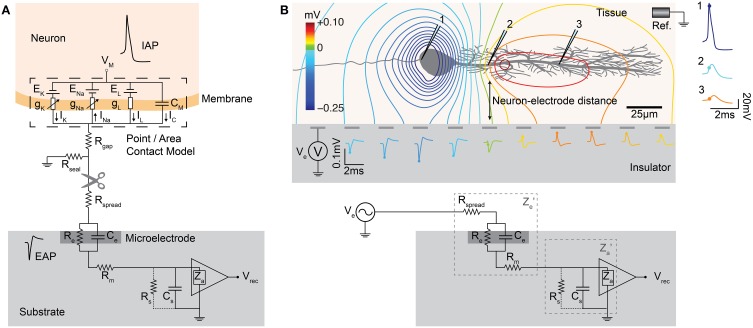
MEA neuron-electrode interface. (A) The classic point or area contact model derived from Fromherz (2003). The cell membrane is represented with an equivalent model based on the Hodgkin-Huxley model of the squid axon (Hodgkin and Huxley, 1952). CM represents the capacitance across the neuronal membrane, i.e., the lipid bilayer. The voltage-gated ion channels (K for potassium and Na for sodium) are represented by non-linear conductances, gK and gNa, and the leak is shown as a linear conductance, gL. The reversal potentials that drive the flow of ions are represented by EK, ENa, and EL. The ion flow is shown by IK, INa, IL, and IC. The other elements are described in the text. Vrec is the recorded voltage signal. Typical IAP and EAP recordings are shown. The location of the scissors indicates where the “cut” can be made to separate the neuron-electrode interface into two parts. (B) Generalized neuron-electrode interface separating the problem into two parts. Upper—“Fluid”-side: The potential at the electrode sites can be solved using the volume conductor theory. The MEA surface is assumed to be an insulator such that the method of images can be applied on Coulomb's law to solve the potential at any point on the MEA surface. The neuron-electrode distance influences the signal amplitude measured at the electrodes. High spatial resolution allows for recording at several locations of a single neuron, with large negative spikes located at the perisomatic area and positive spikes at the dendritic area, i.e., return current. Lower—“Metal”-side: The voltage measured at the electrode is shaped by the electrical parameters of the electrode-electrolyte interface, represented by Z′e as the effective electrode impedance and Z′a as the effective input impedance. This model is derived from Robinson (1968), Nelson et al. (2008), Hierlemann et al. (2011).